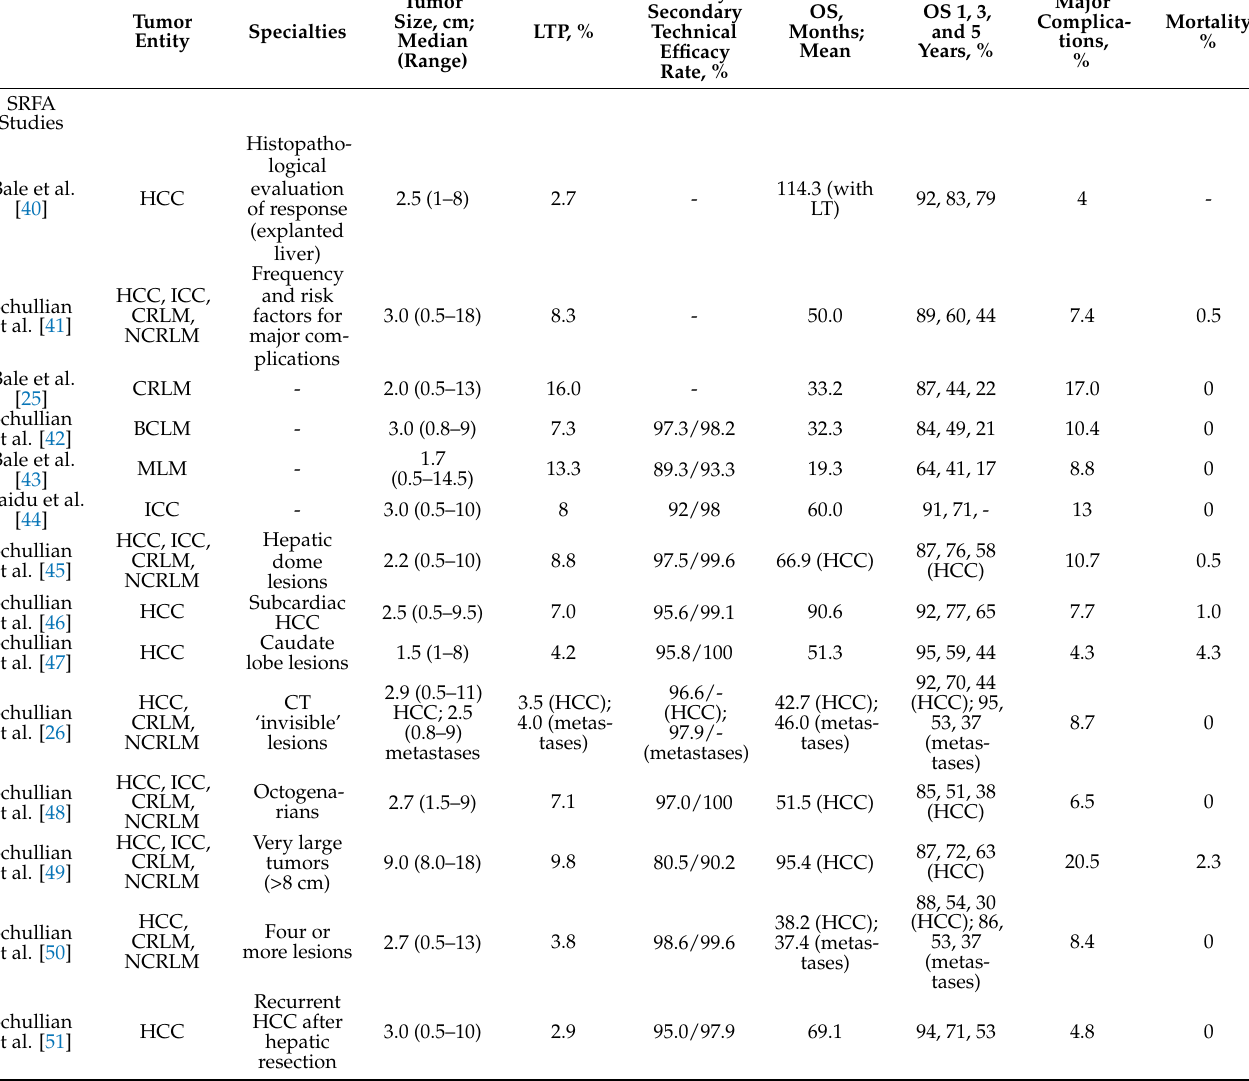
Table 1. Overview of recent studies using stereotactic thermal ablation (SRFA and